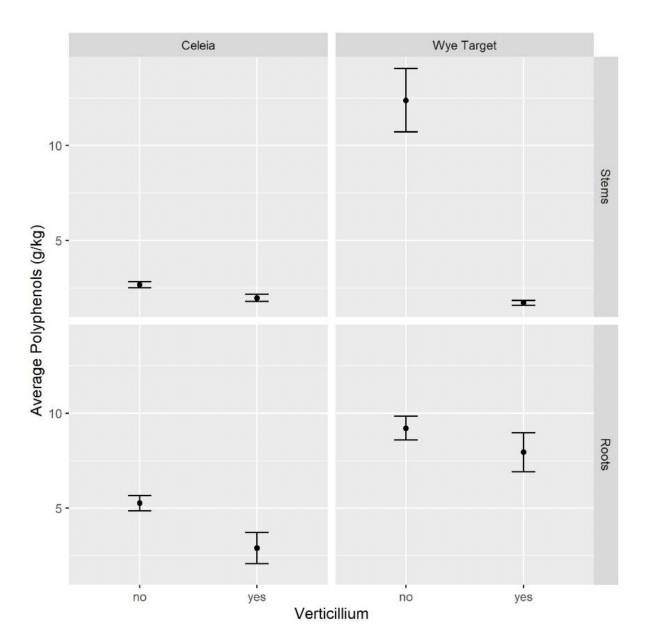
Figure 2. On VW infection, the average total polyphenols content decreases in susceptible hop Celeia and resistant hop Wye Target. Sampling of VW-infected (4 weeks after inoculation) and healthy plants was performed in triplicate at the leaf developmental stage (BBCH 17–19). Total polyphenols were determined spectrophotometrically as described in [43]. Verticillium nonalfalfae (isolate T2; lethal pathotype PV1) was used as the inoculum for root dipping [44]. Data are means ± SE ( n = 3).